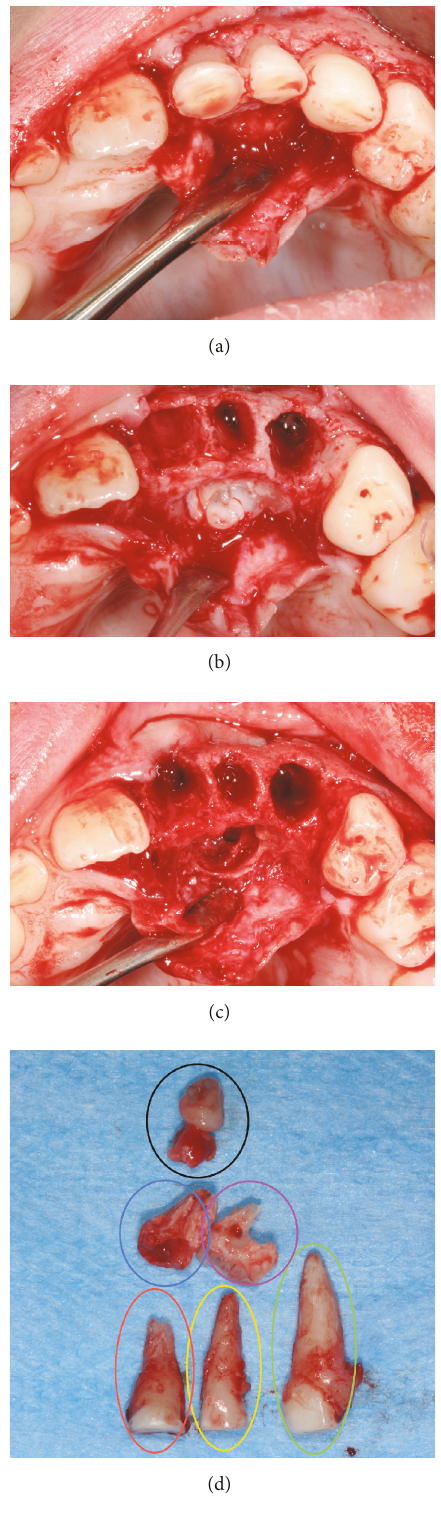
Figure 4: (a) Intraoral view after soft tissue elevation. (b) Intrasur- gical view after the extraction of deciduous teeth and the exposure of the supernumeraries. (c) The alveolar site free from supernumerary teeth. (d) Deciduous and supernumerary teeth after the extraction. They are indicated with the same colours used in Figure 3(a). Third and fourth supernumeraries can be